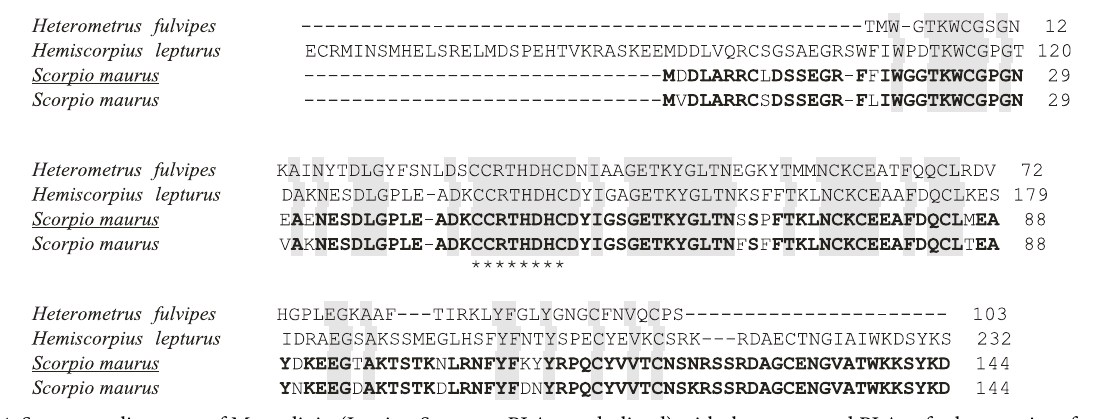
: underlined) with three reported PLA of other species of scorpions, 2 2